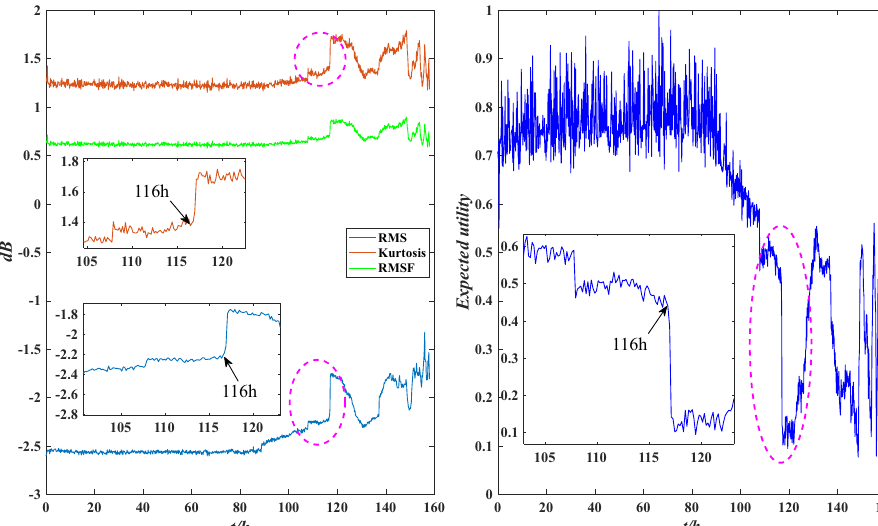
Figure 20. Local indicators and utility comparisons.